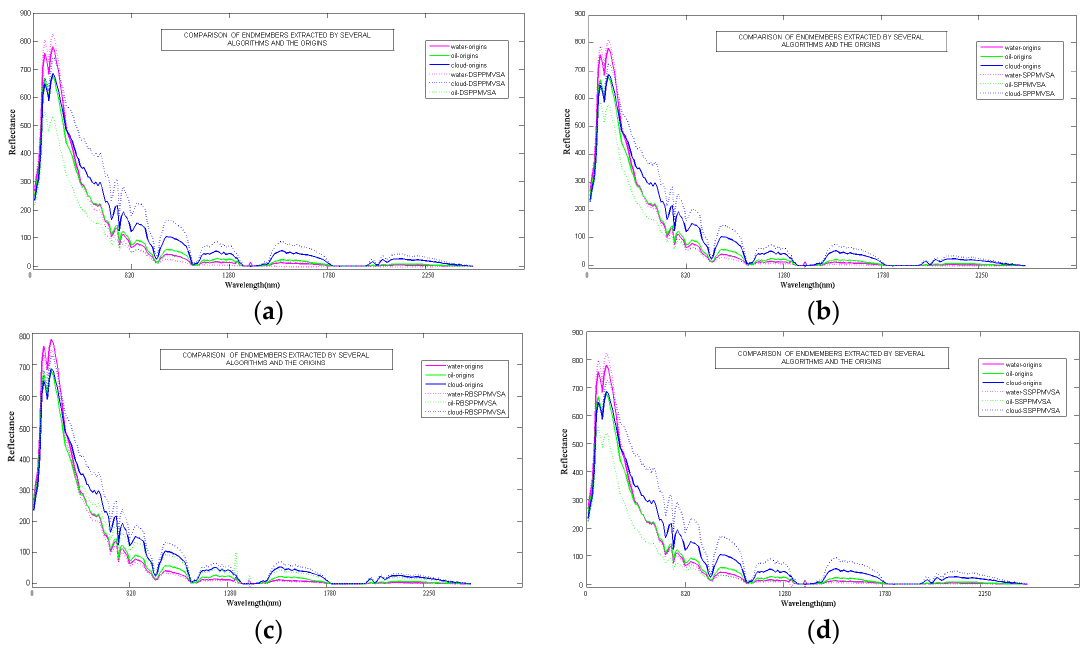
Figure 17. Comparison of the endmembers extracted using several different algorithms and their origins. ( a ) DSPP+MVSA; ( b ) SPP+ MVSA; ( c ) RBSPP+ MVSA; ( d ) SSPP+ MVSA.